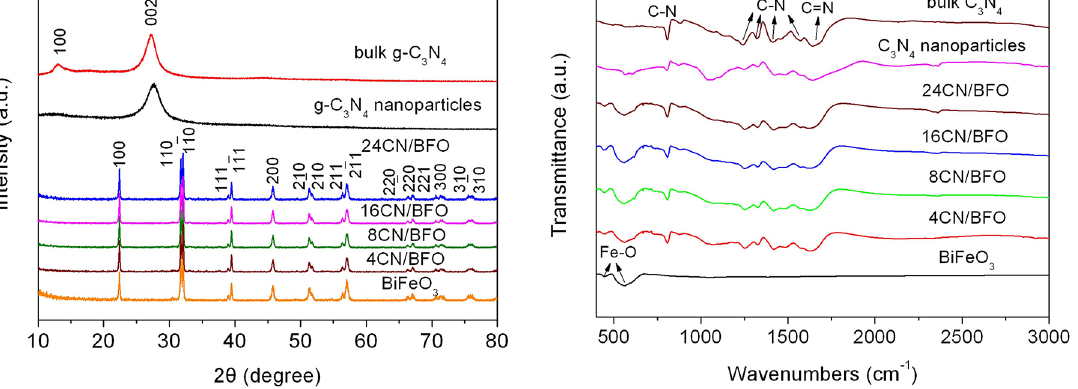
Figure 1. XRD patterns of bulk g-C BiFeO